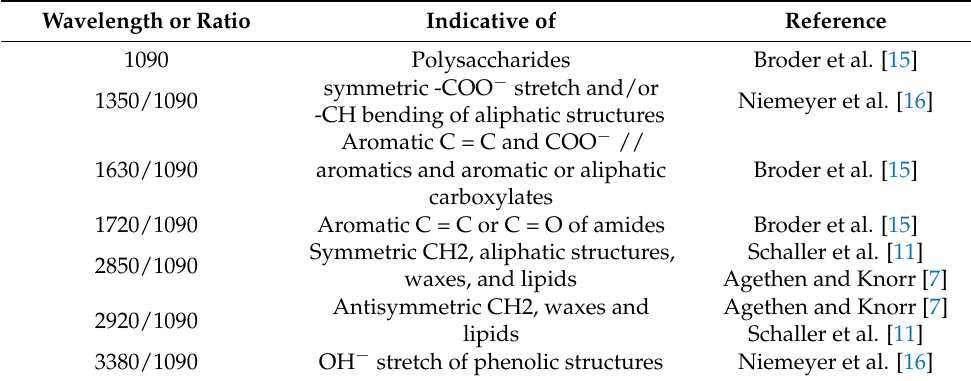
Table 1. Wavenumbers used for FTIR ratios, their indication and